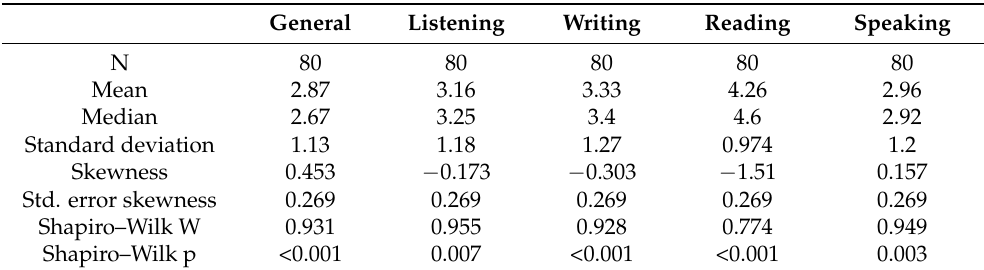
Table 2. Descriptives of language